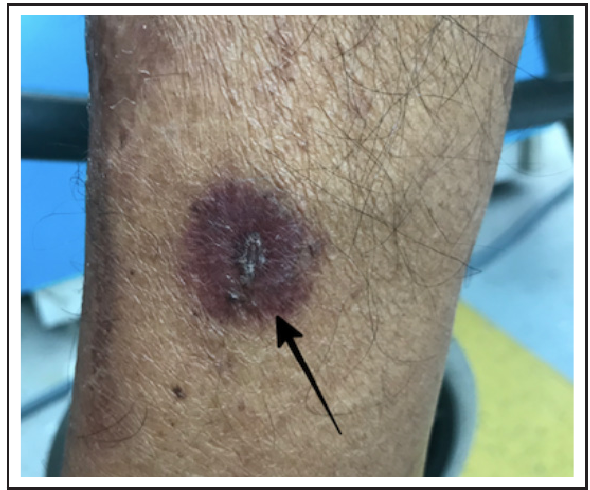
Figure 2. Well defined, erythematous to dusky red, slightly raised circular plaque of 1.5 cm diameter, with central black and white necrotic scale crust on medial aspect of lower